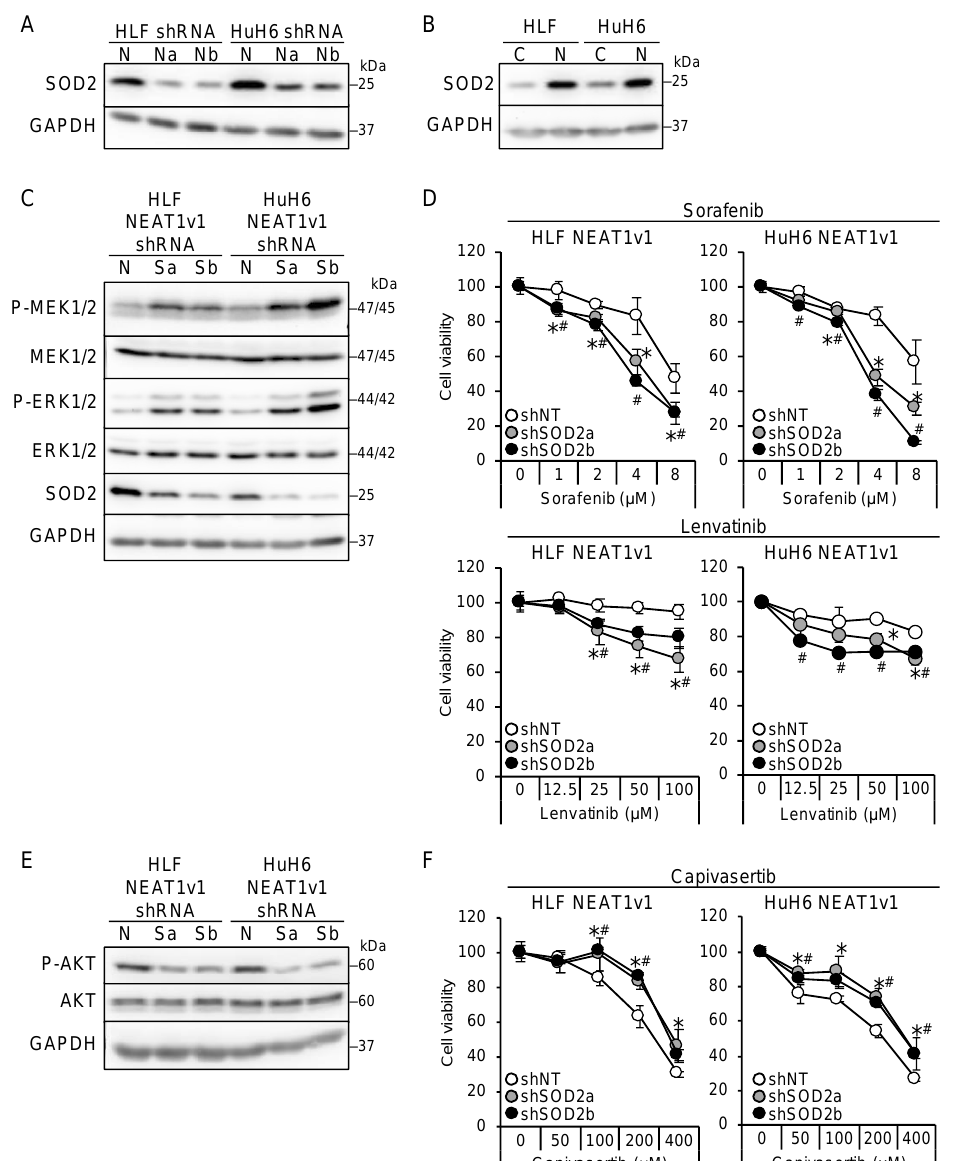
Figure 4. NEAT1v1 regulates cell growth modality through SOD2. ( A ) Representative Western blot images for SOD2 expression in HLF and HuH6 cells transduced with adenoviruses expressing shNT (N), shNEAT1a (Na), or shNEAT1b (Nb) for 48 h. GAPDH is shown as an internal control. ( B ) Rep- resentative Western blot images for SOD2 expression in control ( C ) or NEAT1v1-overexpressing (V1) HLF and HuH6 cells. ( C , E ) Representative Western blot images for the indicated proteins in NEAT1v1-overexpressing cells transduced with adenoviruses expressing shNT (N) or SOD2-specific shRNAs [shSOD2a (Sa) and shSOD2b (Sb)] for 48 h. ( D , F ) Viabilities of cells treated with sorafenib ( D ), lenvatinib ( D ), or capivasertib ( F ) at the concentrations indicated in the figure for 48 h relative to cells treated with DMSO (100%). NEAT1v1-overexpressing cells were transduced with adenoviruses expressing shNT, shSOD2a, and shSOD2b 48 h before drug treatment. * p < 0.05 vs. shNT vs. shSOD2a; # p < 0.05 shNT vs. shSOD2b (Dunnett’s test; n = 4). 3.5. NEAT1v1 or SOD2 Knockdown Suppresses AKT Activity Independent of ER Stress Unfolded protein accumulation in the endoplasmic reticulum (ER) causes ER stress, which triggers several pathways, including PERK/EIF2 α , IRE1 α /XBP1, and ATF6, to adapt to stress [23]. Upon increased ER stress, PERK is activated by self-phosphorylation and phosphorylates EIF2 α . IRE1 α , also activated by self-phosphorylation, executes XBP1